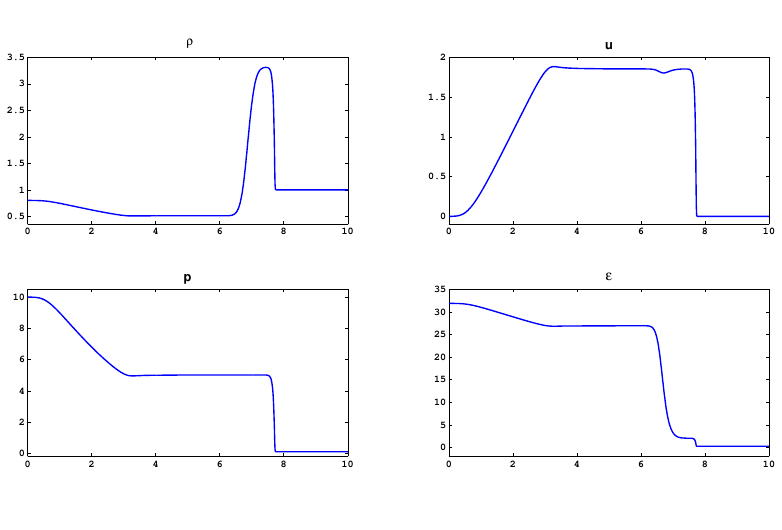
Figure 3. Test 2 (the stiffened gas): the space graphs at time t fin = 0 .